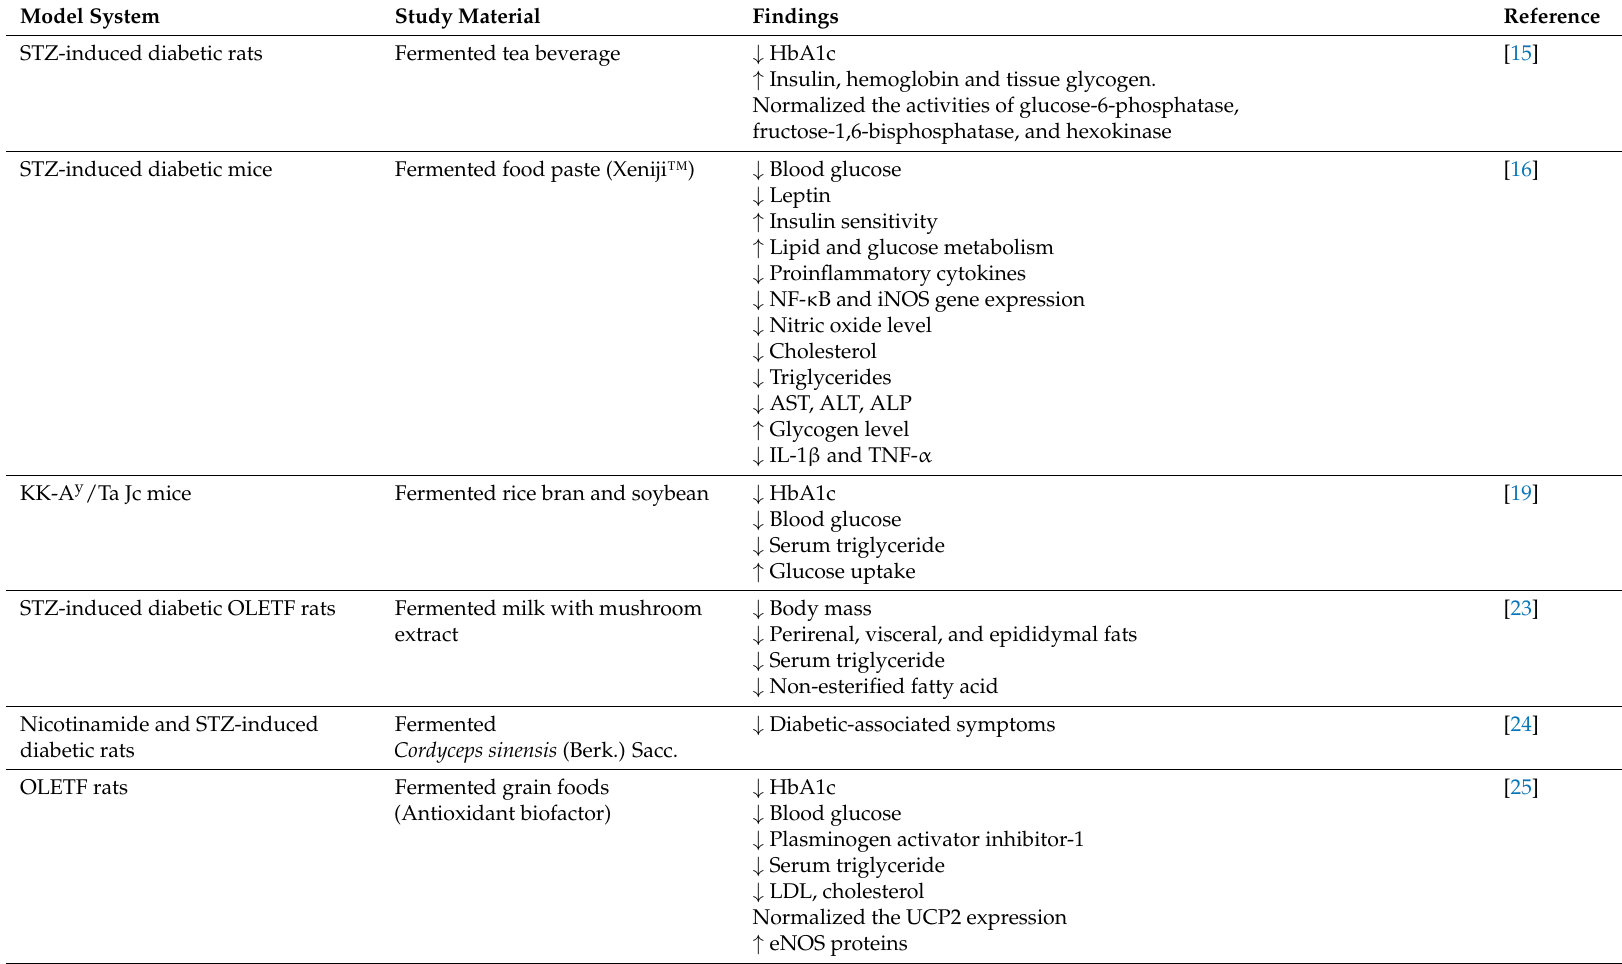
Table 2. Reported in vivo studies in animal models revealing the antidiabetic properties of fermented